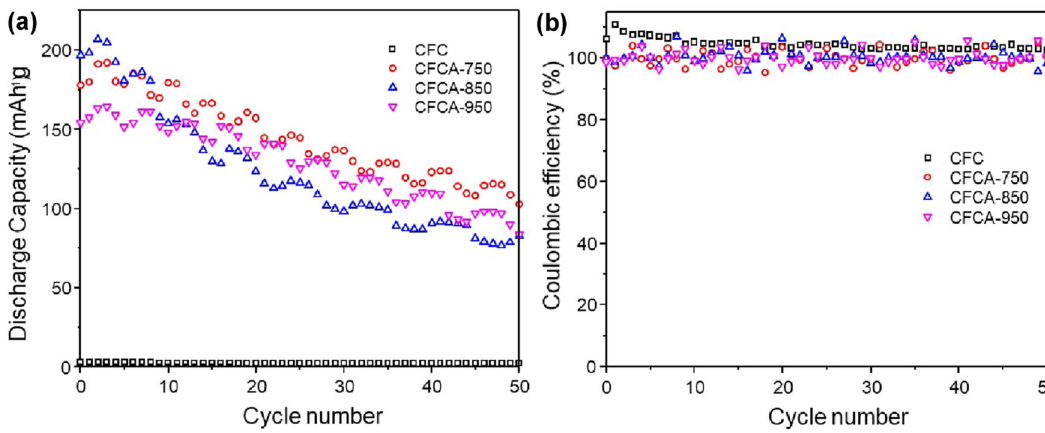
Fig. 8 a Cycling performance, and b columbic efficiency of CFC and